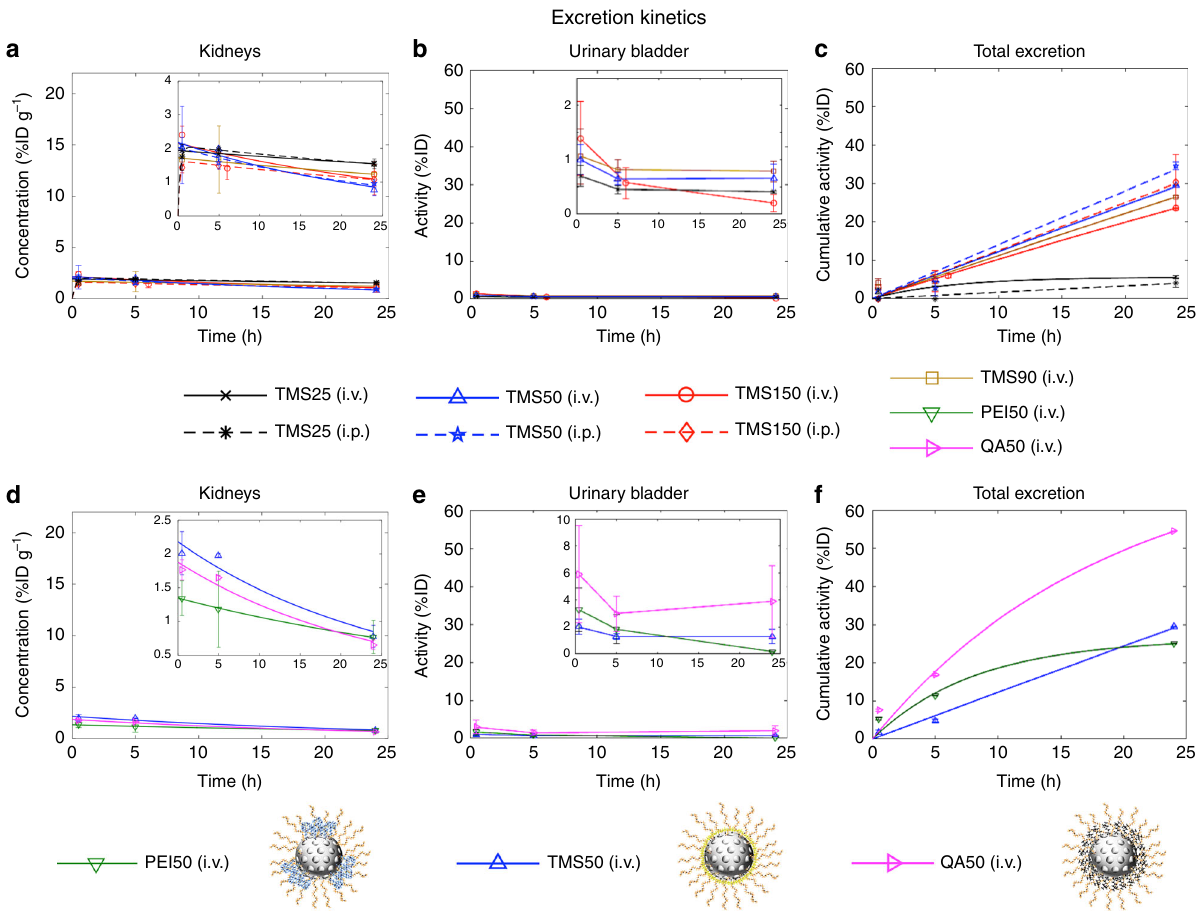
Fig. 6 Excretion kinetics. Urine and feces were not collected during the in vivo study, we thus examine the kidneys, urinary bladder, and total excreted activity to infer excretion kinetics of MSNs. a , d Concentration – time data of kidneys was fi t to Eq. (6) for i.v. cases and Eq. (4) for i.p. cases. b , e No model was fi t to the urinary bladder activity data due to the lack of urine collection. Data are presented as activity in the bladder as a percentage of the injected dose (%ID) over time. c , f To the total excreted activity (100%ID — whole-body activity) data, Eq. (7) was fi t to all cases (Supplementary Tables 4 and 5). The insets in a , b , d , and e are rescaled versions of their corresponding fi gures for a clearer view. Solid lines, i.v. cases; dotted lines, i.p. cases. Data represent mean ± s.d., n = 4 (except TMS50 (i.p.) and TMS25 (i.p.), where n =